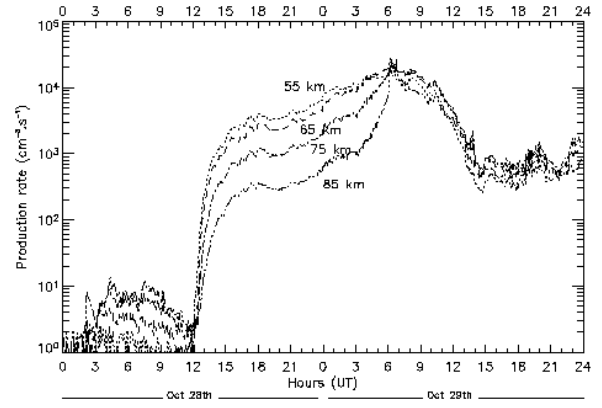
Fig. 7. Production rates at 55, 65, 75 and 85km computed from proton spectra observed by GOES-11.